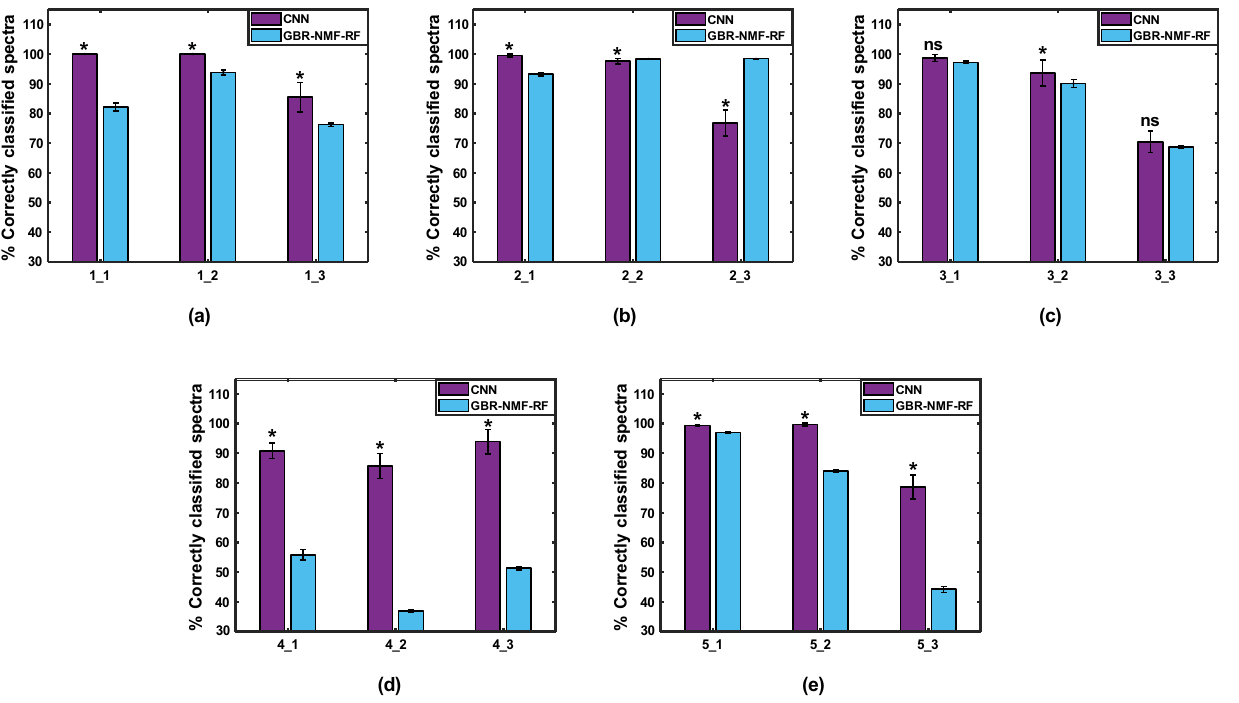
Figure 10. Percentage of correctly classified spectra (test accuracy) corresponding to each tumour section removed from the training set (leave-one-section-out validation). Section labels given as mouse number_ (section #). *p < 0.05, ns = not